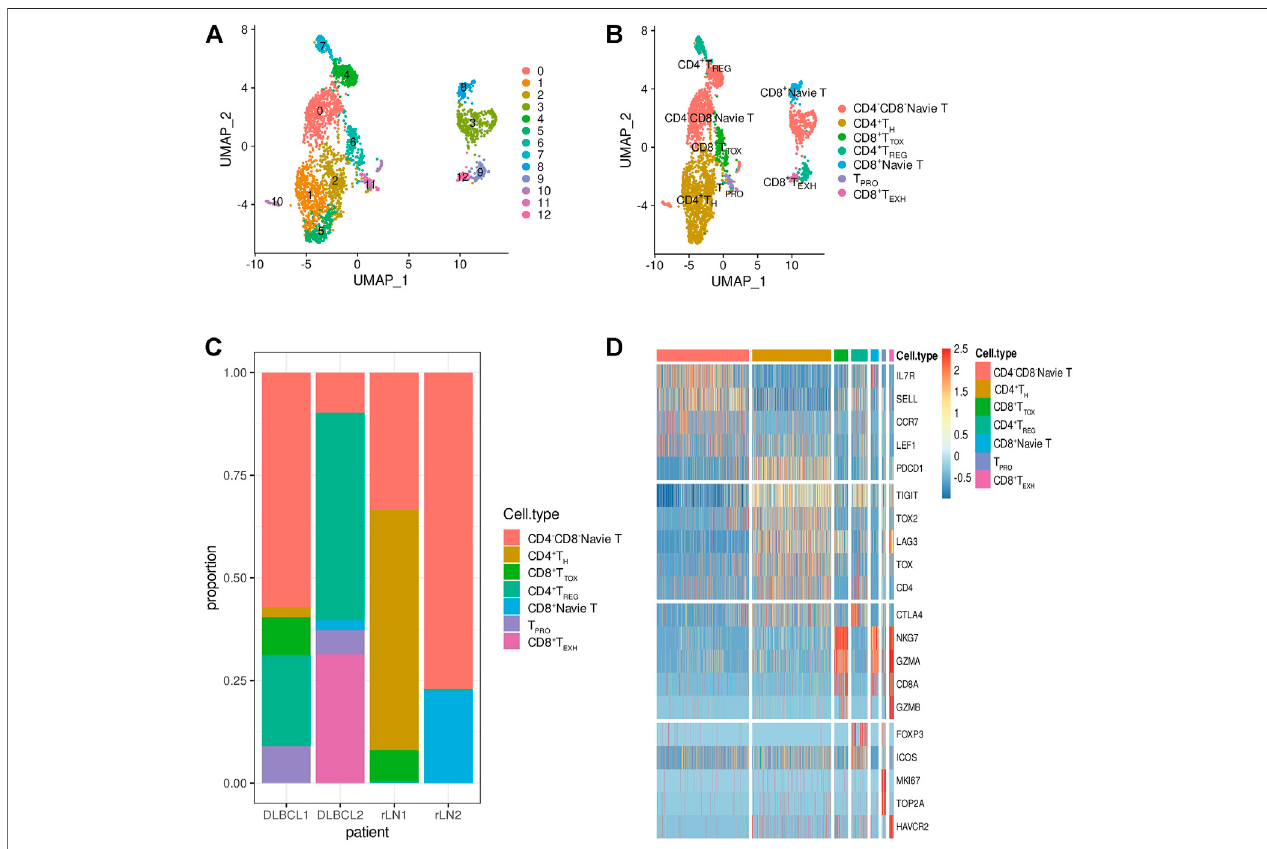
FIGURE 3 | Transcriptome heterogeneity in T cells. (A,B) T cells from 4 samples were combined and visualized using UMAP association. Cells were colored according to their cluster or subtype. (C) Bar graph showing the proportion of cell types in each sample. (D) Differentially expressed genes used to identify T cell